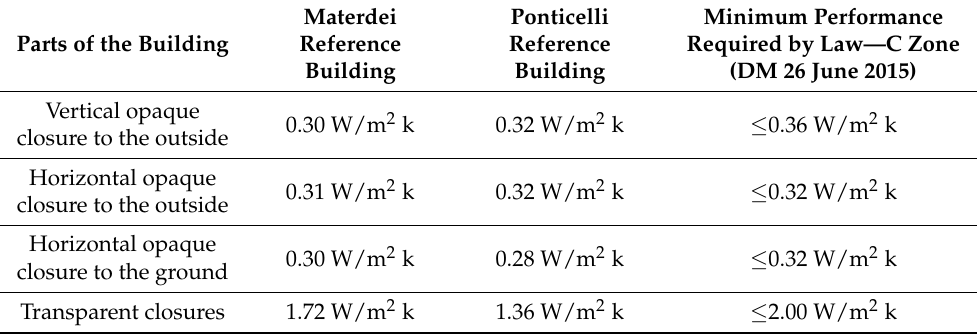
Table 12. The thermal transmittances of the parts of the building envelope for the two involved buildings as a result of retrofitting actions.